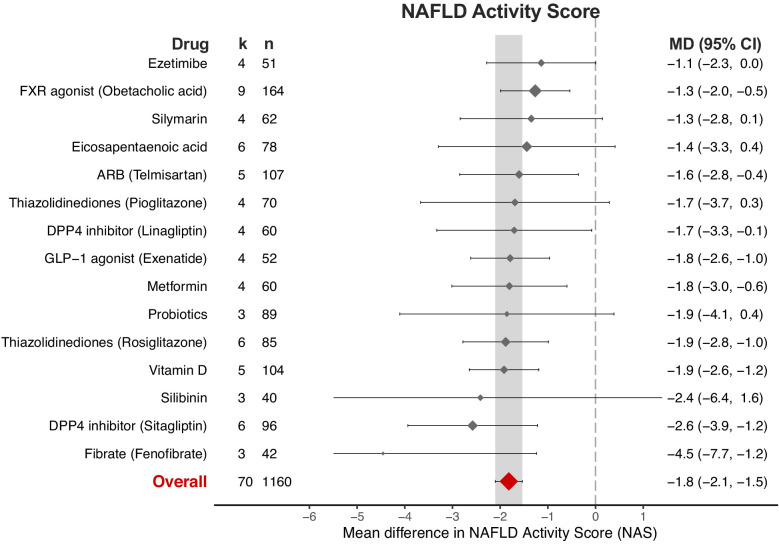
Meta-analysis of NAFLD Activity Score (NAS) in rodent studies of NAFLD by individual drug.Forest plot with subgrouping by individual drug. Individual studies have been hidden and only subgroup summaries are illustrated. k represents the number of cohorts in each subgroup. Total animals is the sum of control and interventional animals for each subgroup. ARB, angiotensin receptor blocker; CI, confidence interval; DPP4, Dipeptidyl peptidase-4; FXR, Farnesoid X receptor; MD, mean difference.